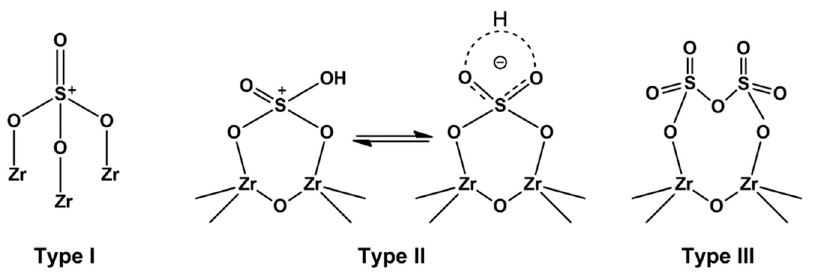
Scheme 1. Three different types of sulfate species on SZ catalysts.